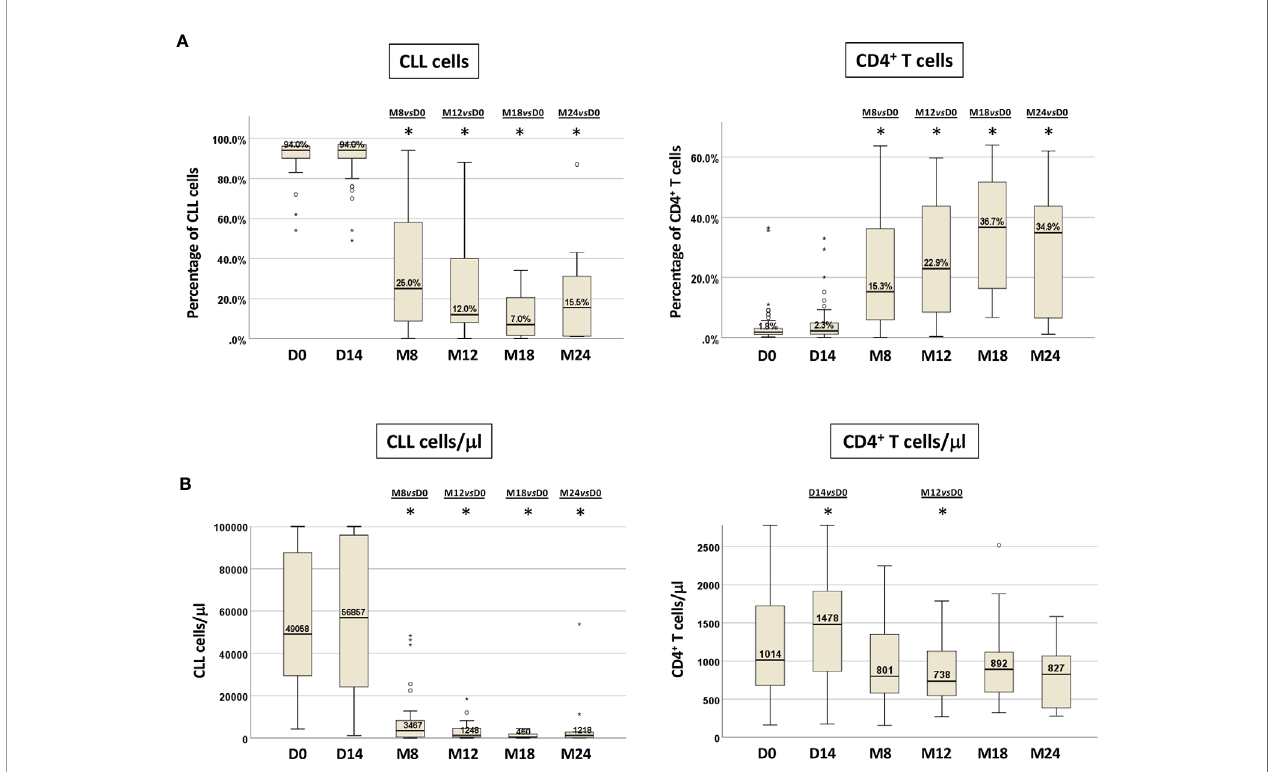
FIGURE 2 | CLL cells and CD4 + T cells in paired PB samples before and during ibrutinib treatment. Percentage (A) and absolute number (B) of CLL cells and CD4+ T cells from paired samples included in the longitudinal analysis. Samples at D0, n=71; at D14, n=50; at M8, n=30; at M12, n=25; at M18, n=22; at M24, n=10 (Wilcoxon paired test D14 vs D0, M8 vs D0, M12 vs D0, M18 vs D0, M24 vs D0;